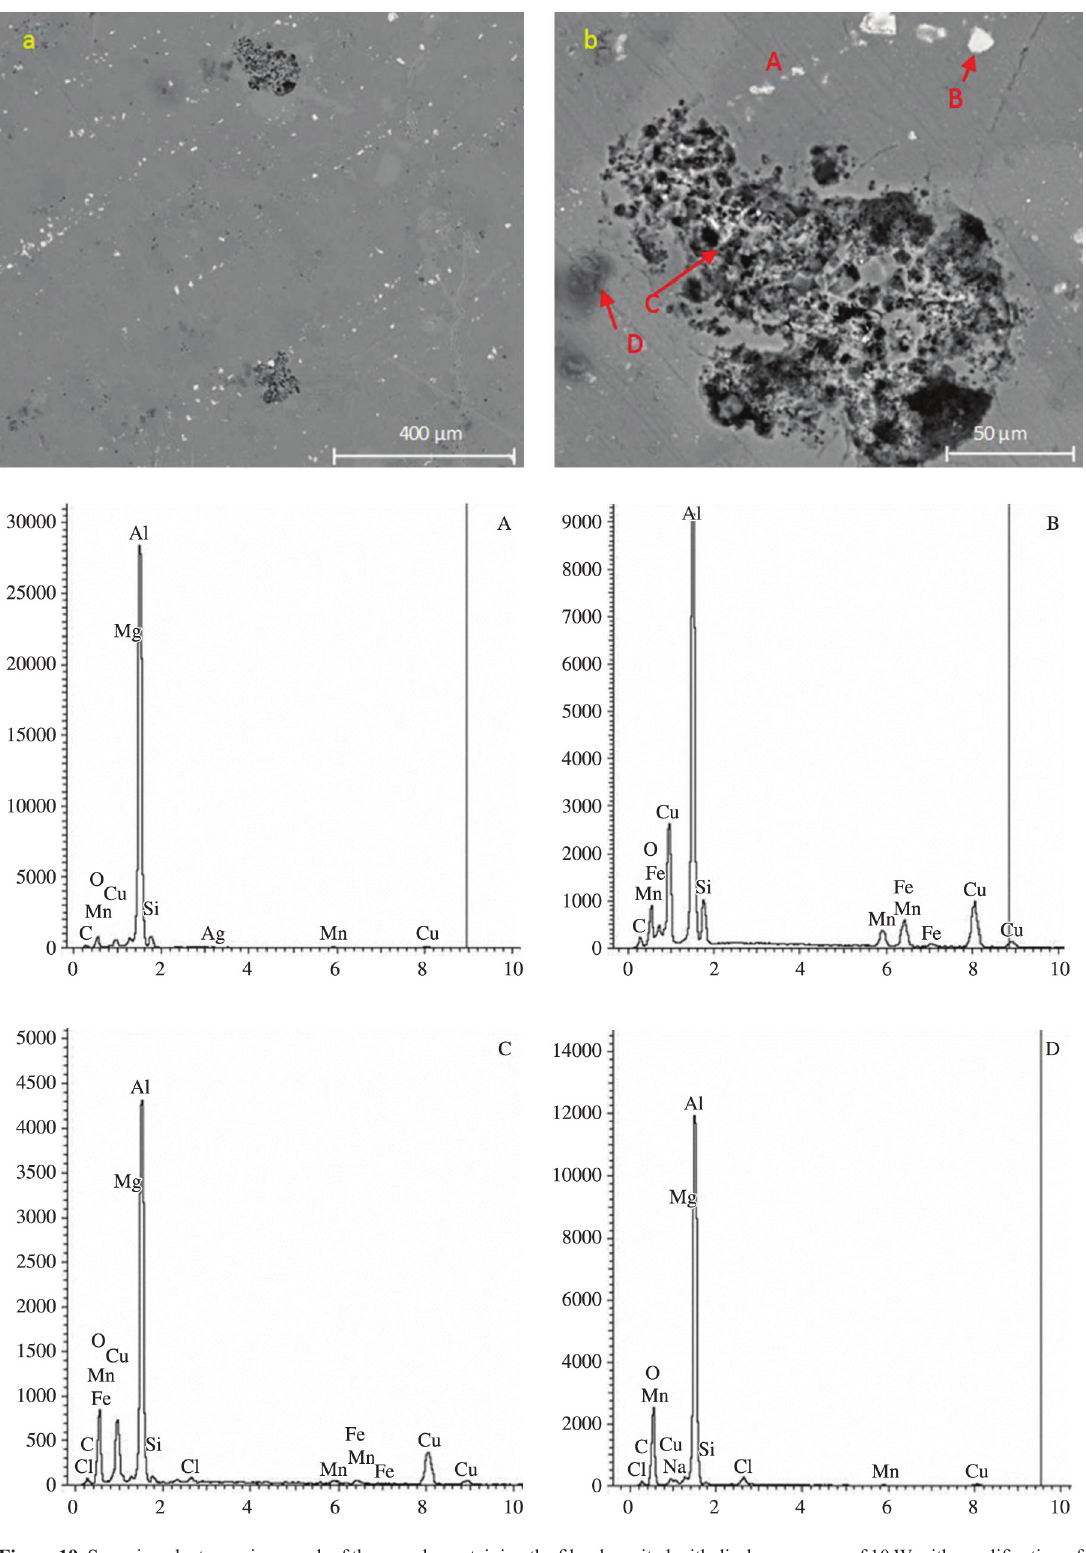
Figure 19. Scanning electron micrograph of the sample containing the film deposited with discharge power of 10 W with amplification of (a) 250 times and (b) 1500 times. A, B, C and D are energy dispersive spectra of the regions A, B, C and D of the micrograph shown in